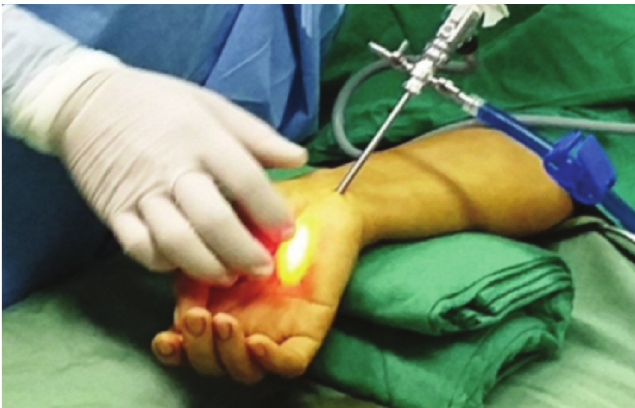
Determination of the second incision. Fig. 1: